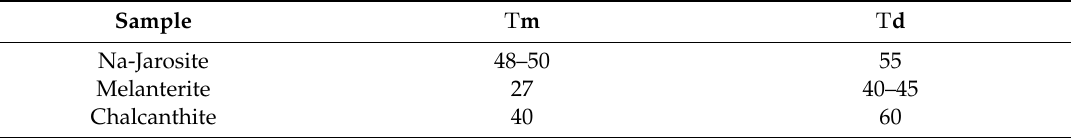
Table 3. Dehydration temperature of the crystalline hydrates, ° С .